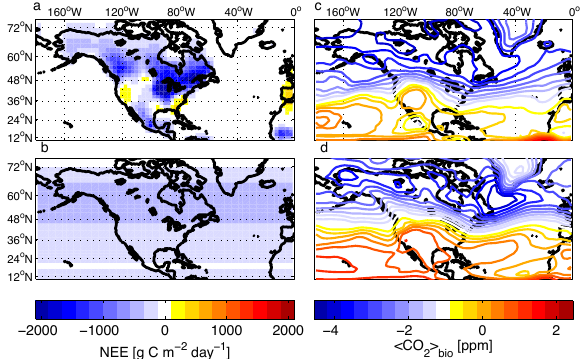
Fig. 6. (a) August-mean NEE from the CASA model. Fluxes over the ocean are zero, and land fluxes are generally negative, indicat- ing uptake of carbon by the terrestrial biosphere. (b) Zonal mean August NEE. Fluxes over land and ocean at a given latitude are the same, and there are only weak north-south gradients in fluxes over the Northern Hemisphere. Nonetheless, gradients in h CO 2 i bio are similar for both distributions of underlying surface fluxes ( c and d